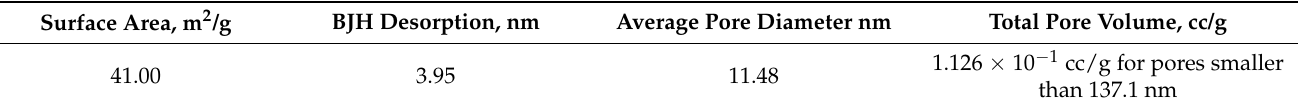
Table 1. Textural parameters of sample BCb/CB.